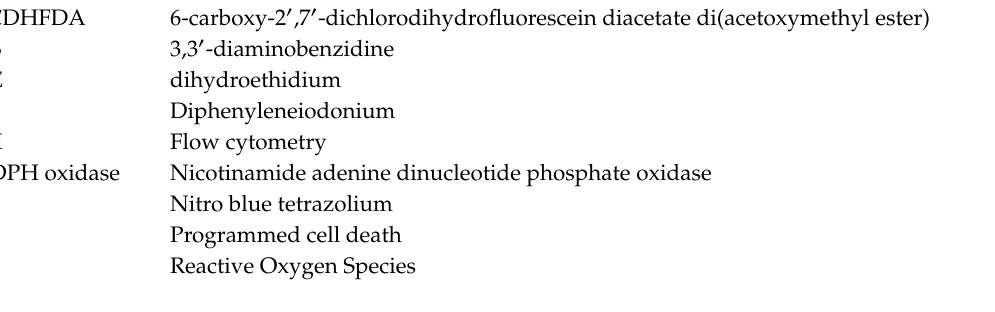
Figure S1: Detection and localization of O 2 •− and H 2 O 2 in Avena fatua seeds incubated in water at 20 ◦ C for 8 or 16 h by NBT– or DAB–mediated tissue printing of seeds at 4 min after cutting (representative tissue printing are shown); Figure S2: In situ localization of O 2 •− (a, b) and H 2 O 2 (c, d) in A. fatua seeds incubated in water at 20 ◦ C for 8 or 16 h. After staining whole seeds were cut using razor blade (b, d). Representative stained seeds are shown; Figure S3: In situ localization of O 2 •− and H 2 O 2 in A. fatua seeds incubated in water at 20 ◦ C for 8 or 16 h. After incubation of seeds, longitudinally bisected half seeds were stained. Representative stained seeds are